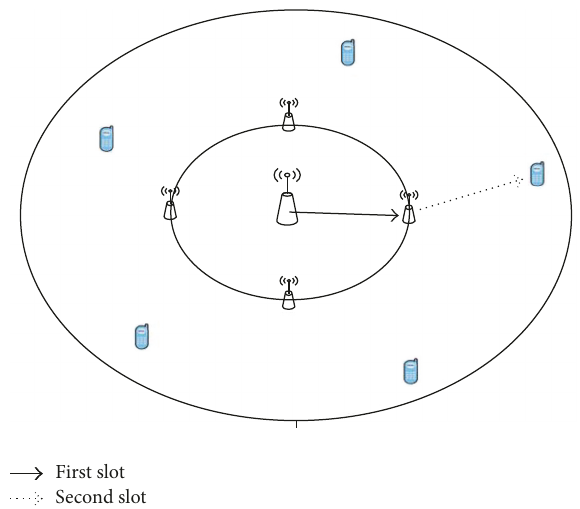
Figure 1: Illustration of dual-hop multi-relay multi-user AF relay-